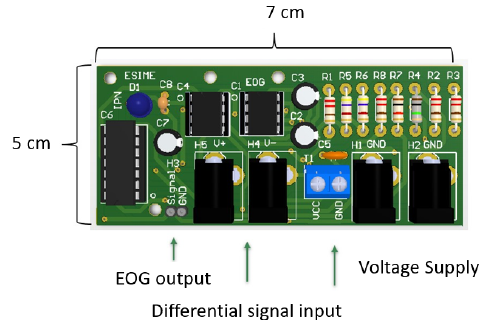
Figure 7. Portable EOG acquisition card. It was designed for analog processing including amplifica- tion, isolation and filtering modules.